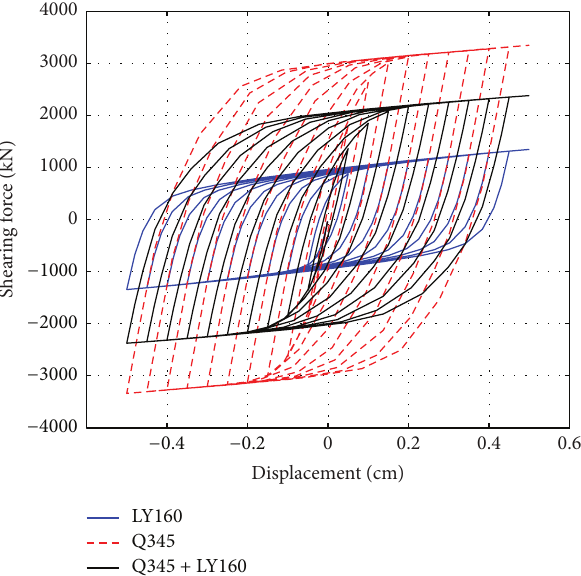
Figure 21: Hysteresis curves of boundary optimized damper.